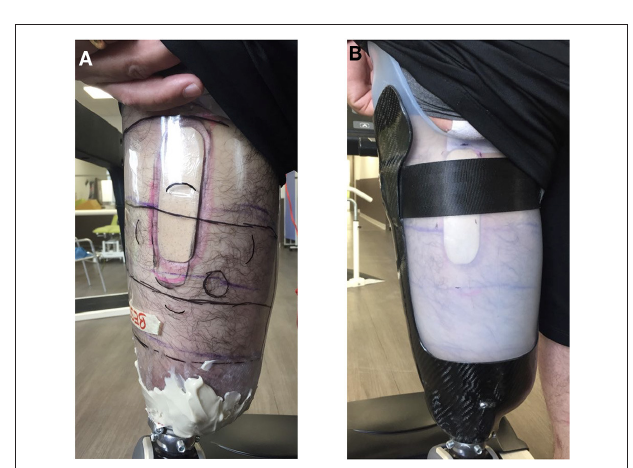
FIGURE 7 | The cork patch placed on the posterior side of the rigid (A) and semi-rigid socket (B) on stimulation areas 8 and 18 (see Figure 6